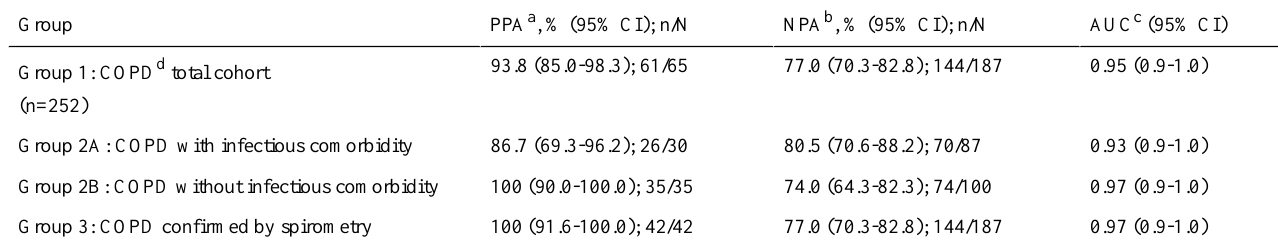
Table 5. PPA, NPA, and calculated AUC of the algorithm (index test) compared with clinical diagnosis (reference